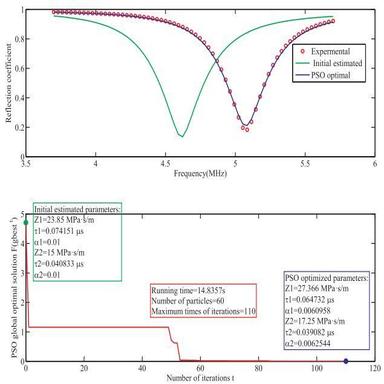
(a) The reflection spectrum of the real measured parameters, initial estimated parameters, PSO optimized parameters and (b) the track of the global optimal solution in the simulation.